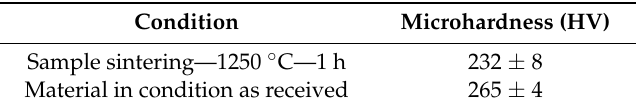
Table 2. Microhardness values of stainless–steel for different conditions.